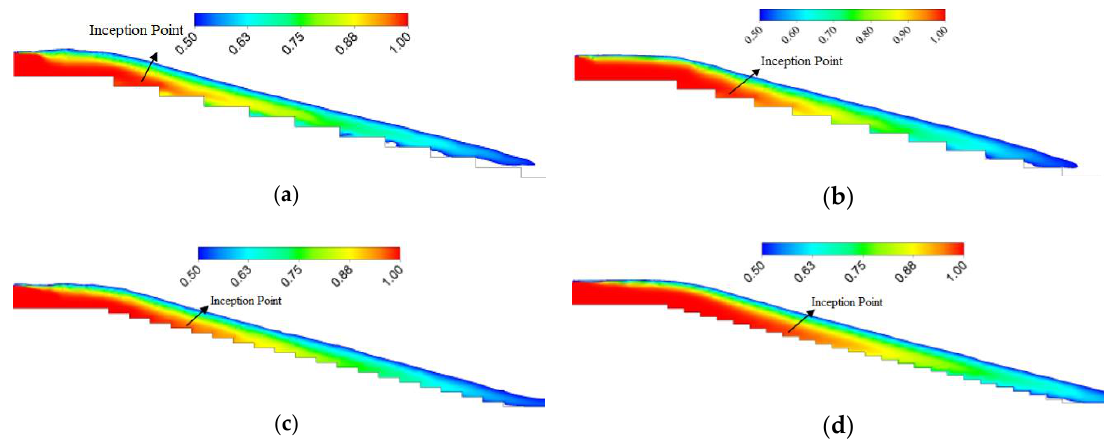
Figure 4. Water volume fraction contours of di ff erent step heights for stepped spillway models in the central plane at discharge 0.8 m 2 / s: ( a ) flat stepped spillway with step height 0.10 m; ( b ) flat stepped spillway with step height 0.09 m; ( c ) flat stepped spillway with step height 0.05 m; and ( d ) flat stepped spillway with step height 0.04 m.